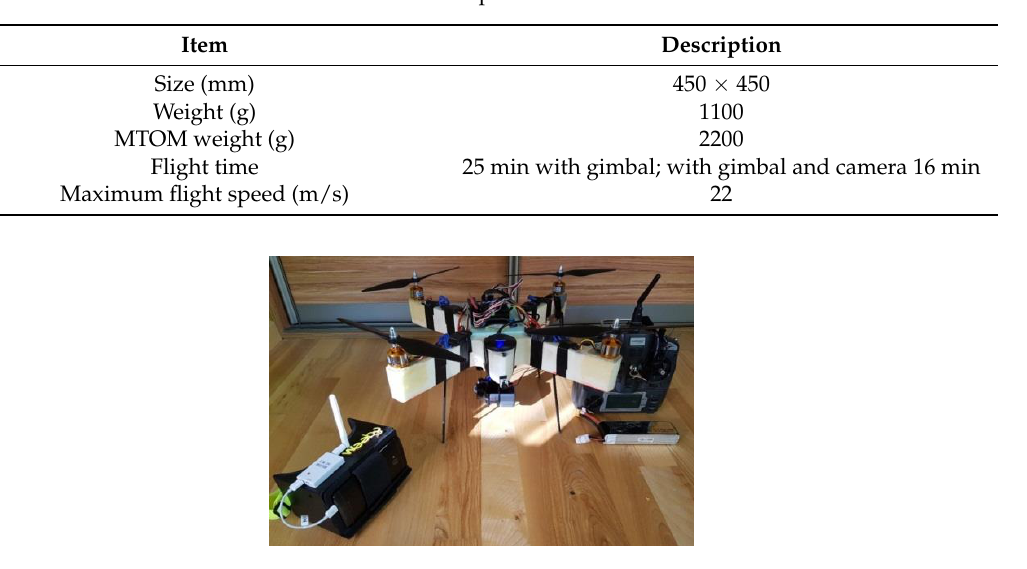
Figure 4. The designed UAV system (from the left: FPV receiver with cardboard, quadcopter with FPV system, mounted gimbal and GoPro camera, control equipment and LiPo battery). Table 2. Technical specification of UAV.